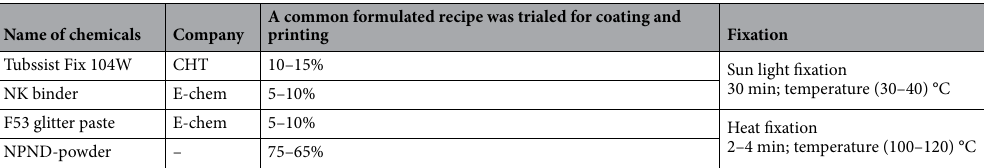
Table 2. Chemicals and formulations for coating and printing with NPND materials on cotton fabric.